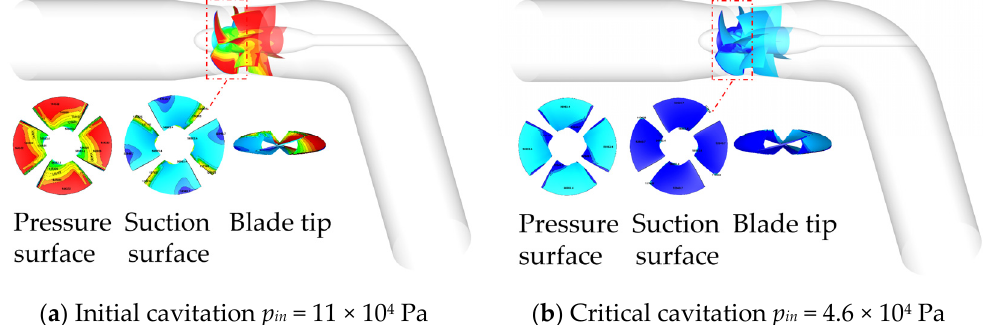
Figure 18. Flow condition Q = 348 L/s pressure distribution cloud diagrams.